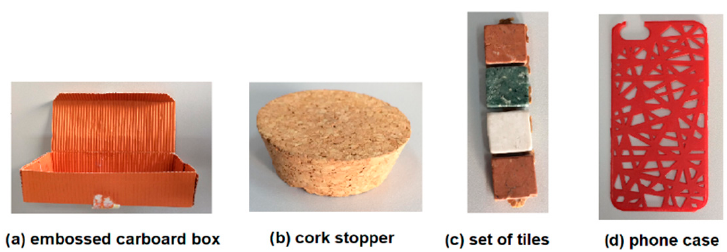
Figure 1. The objects used in the UX experiment.